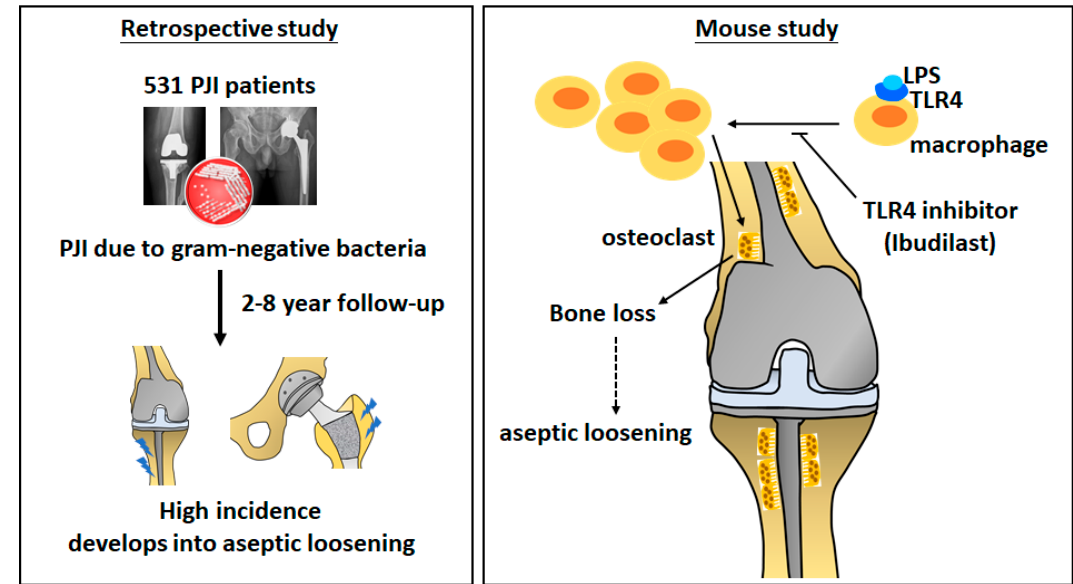
Figure 6. Graphical abstract. We initially conducted a retrospective review of clinical records obtained from 320 patients with bacterial PJI. The results revealed that, compared with GP infections, GN infections were associated with an increased risk of aseptic loosening. In subsequent animal experiments, LPS, but not LTA, was found to reduce both the number of trabeculae and the bone mineral density. LPS accelerated monocyte differentiation into osteoclast-like cells, whereas LTA did not. Finally, ibudilast—a toll-like receptor (TLR)-4 antagonist—successfully inhibited LPS-induced bone loss and osteoclast activation in mice. PJI, periprosthetic joint infection; GP, Gram-positive; GN, Gram-negative; LPS, lipopolysaccharide; LTA, lipoteichoic acid.